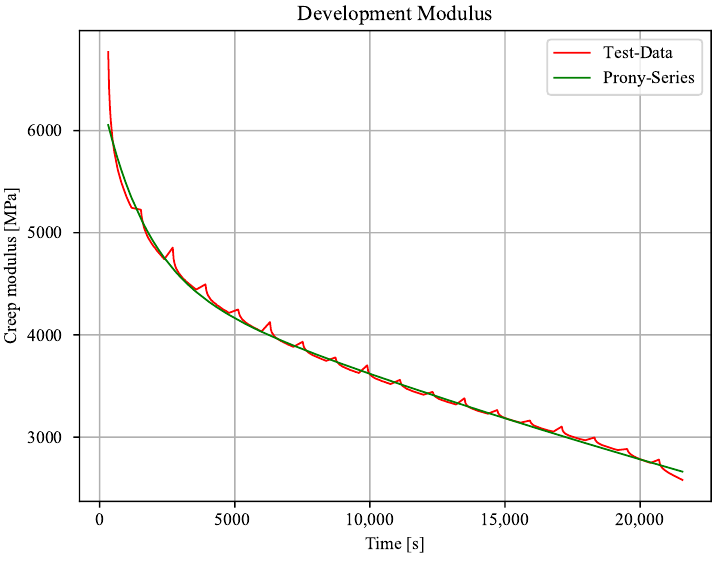
Figure 11. Development of the creep modulus.